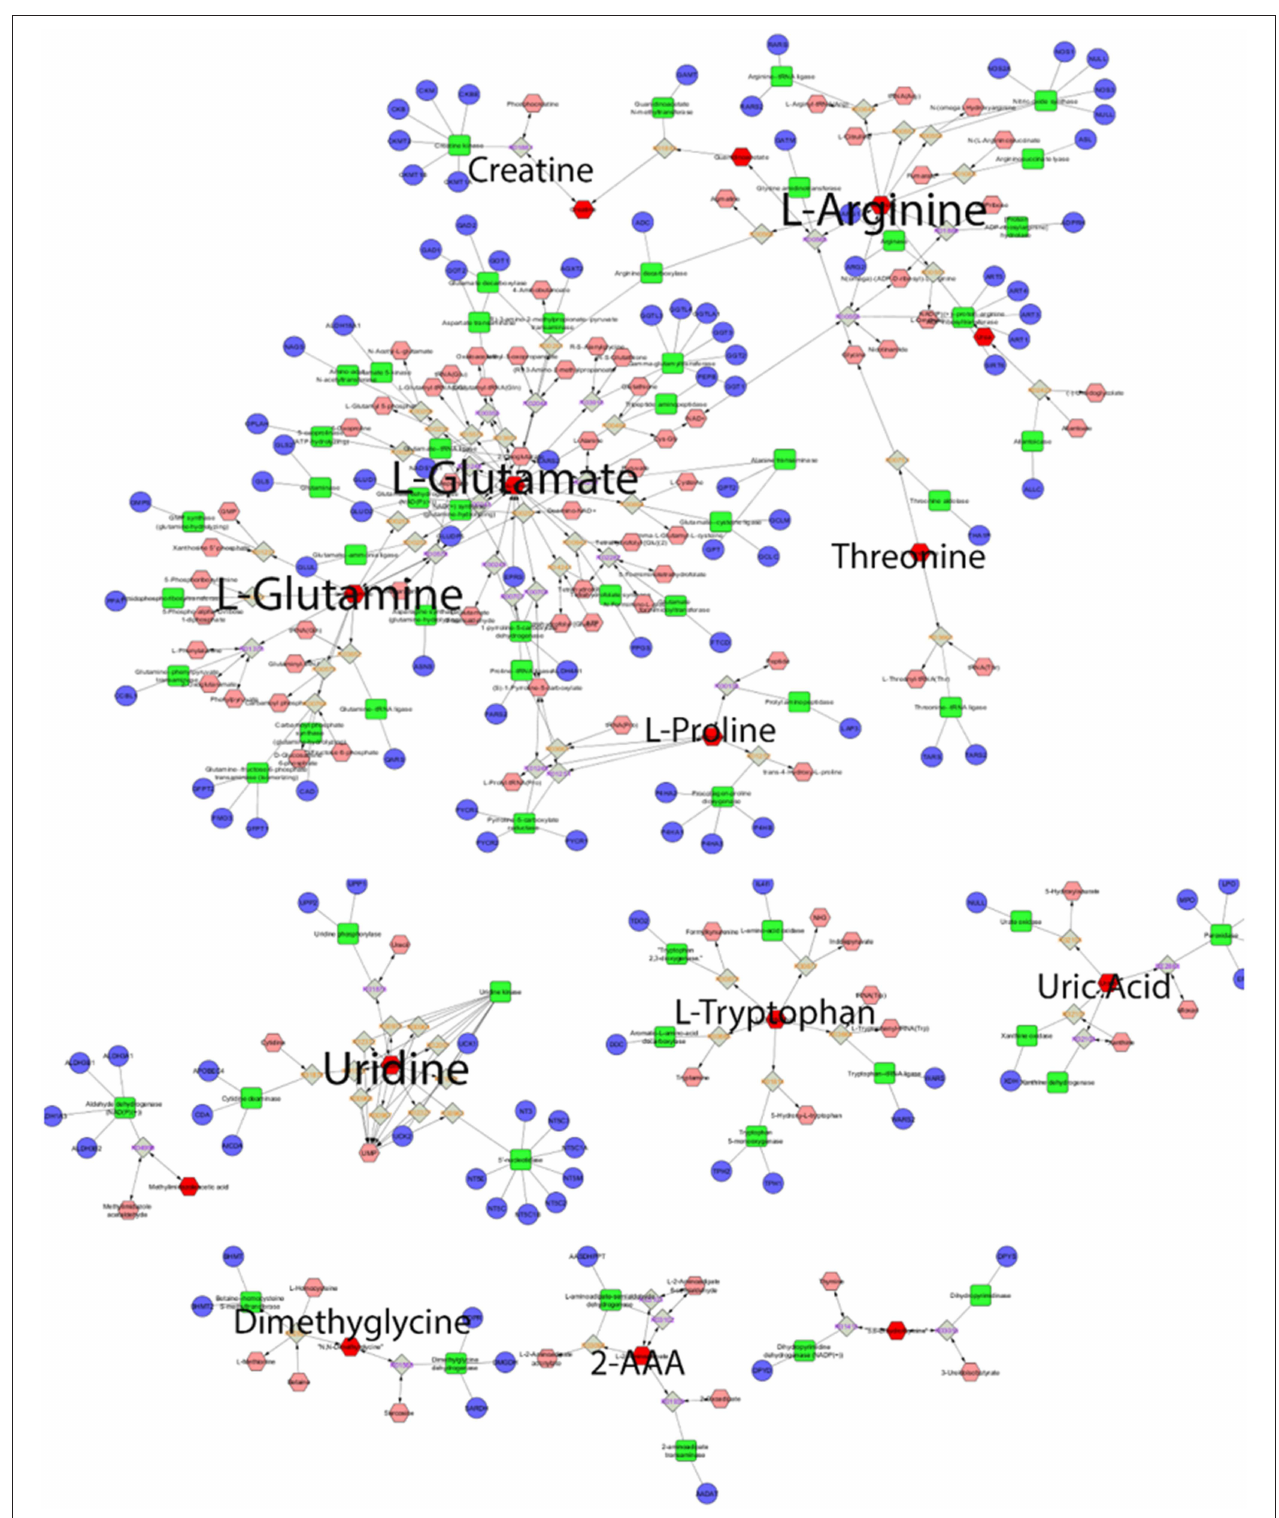
FIGURE 5 | Global metabolic network pathways. Nodes correspond to the identified plasma metabolite, and edges indicate a significant correlation between nodes. Red hexagons represent inputted metabolites; pink hexagons represent compounds, blue circles represent genes, green quadrangles represent enzymes, gray quadrangles represent reaction